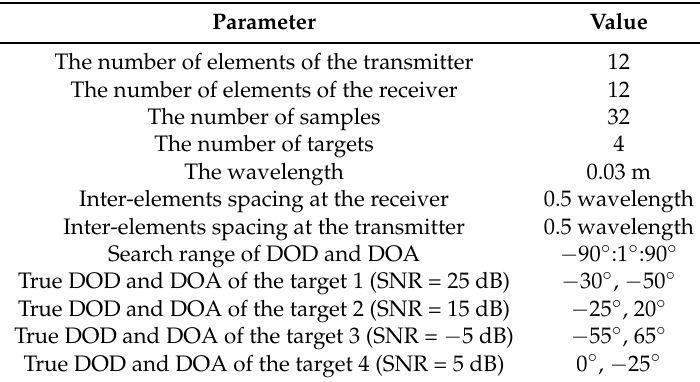
Table 2. Simulation parameters of multiple targets (case